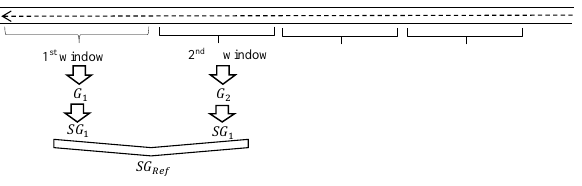
Figure 2: The proposed method for graph stream